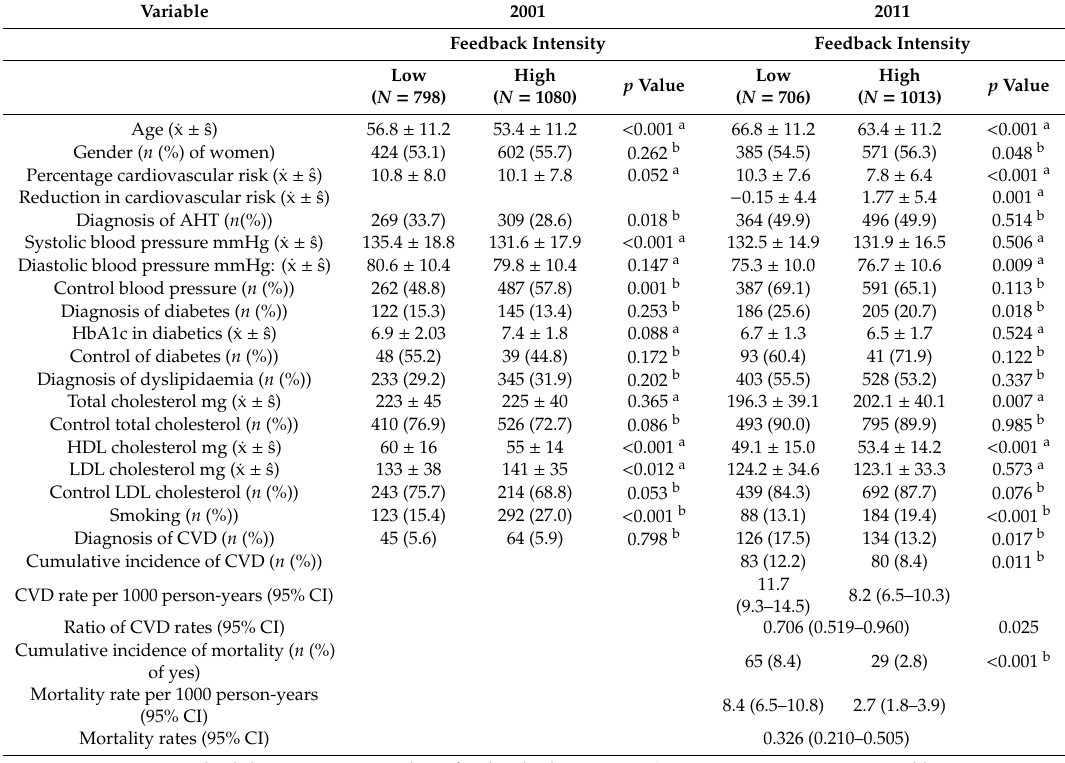
Table 3. Sociodemographic characteristics and indicators of health, cardiovascular disease and mortality at baseline and at of the 10-year follow-up according to feedback